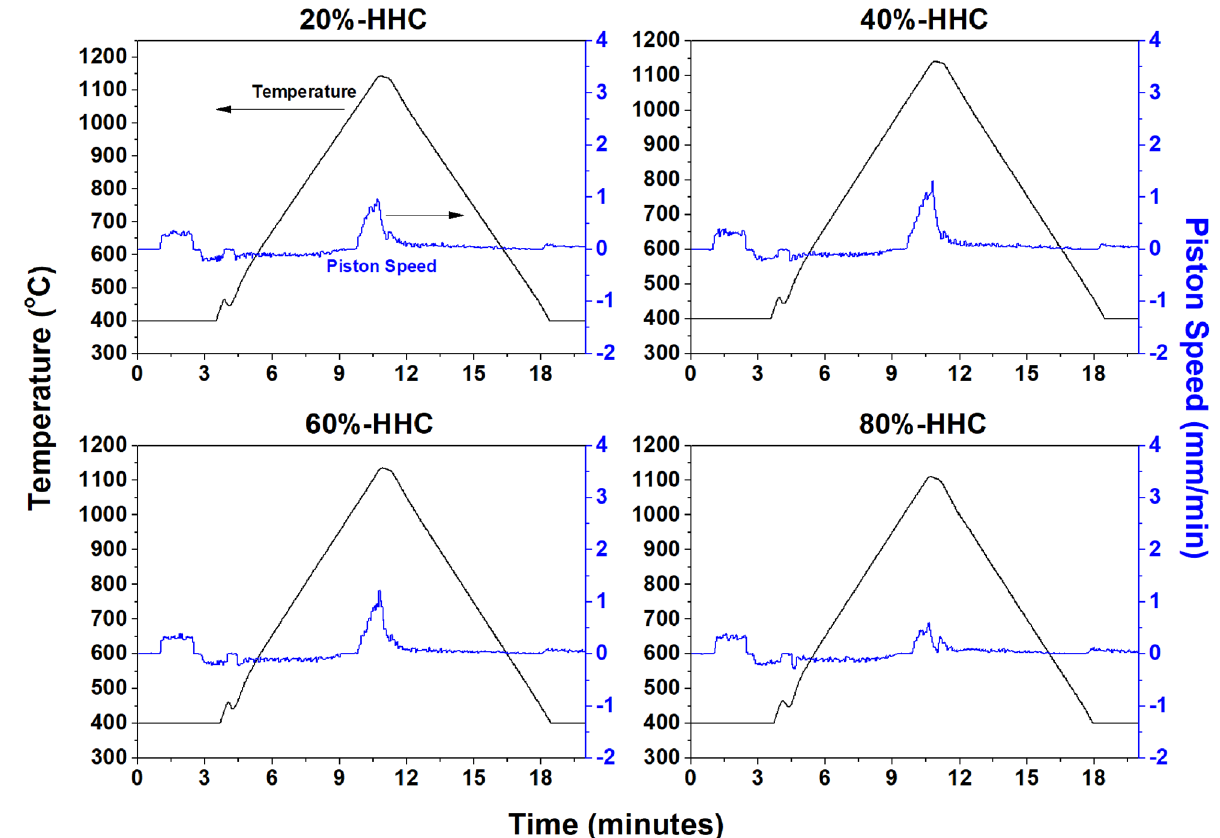
Figure 5. SPS densification curves of high Cs content hollandite composition (HHC) designer waste form